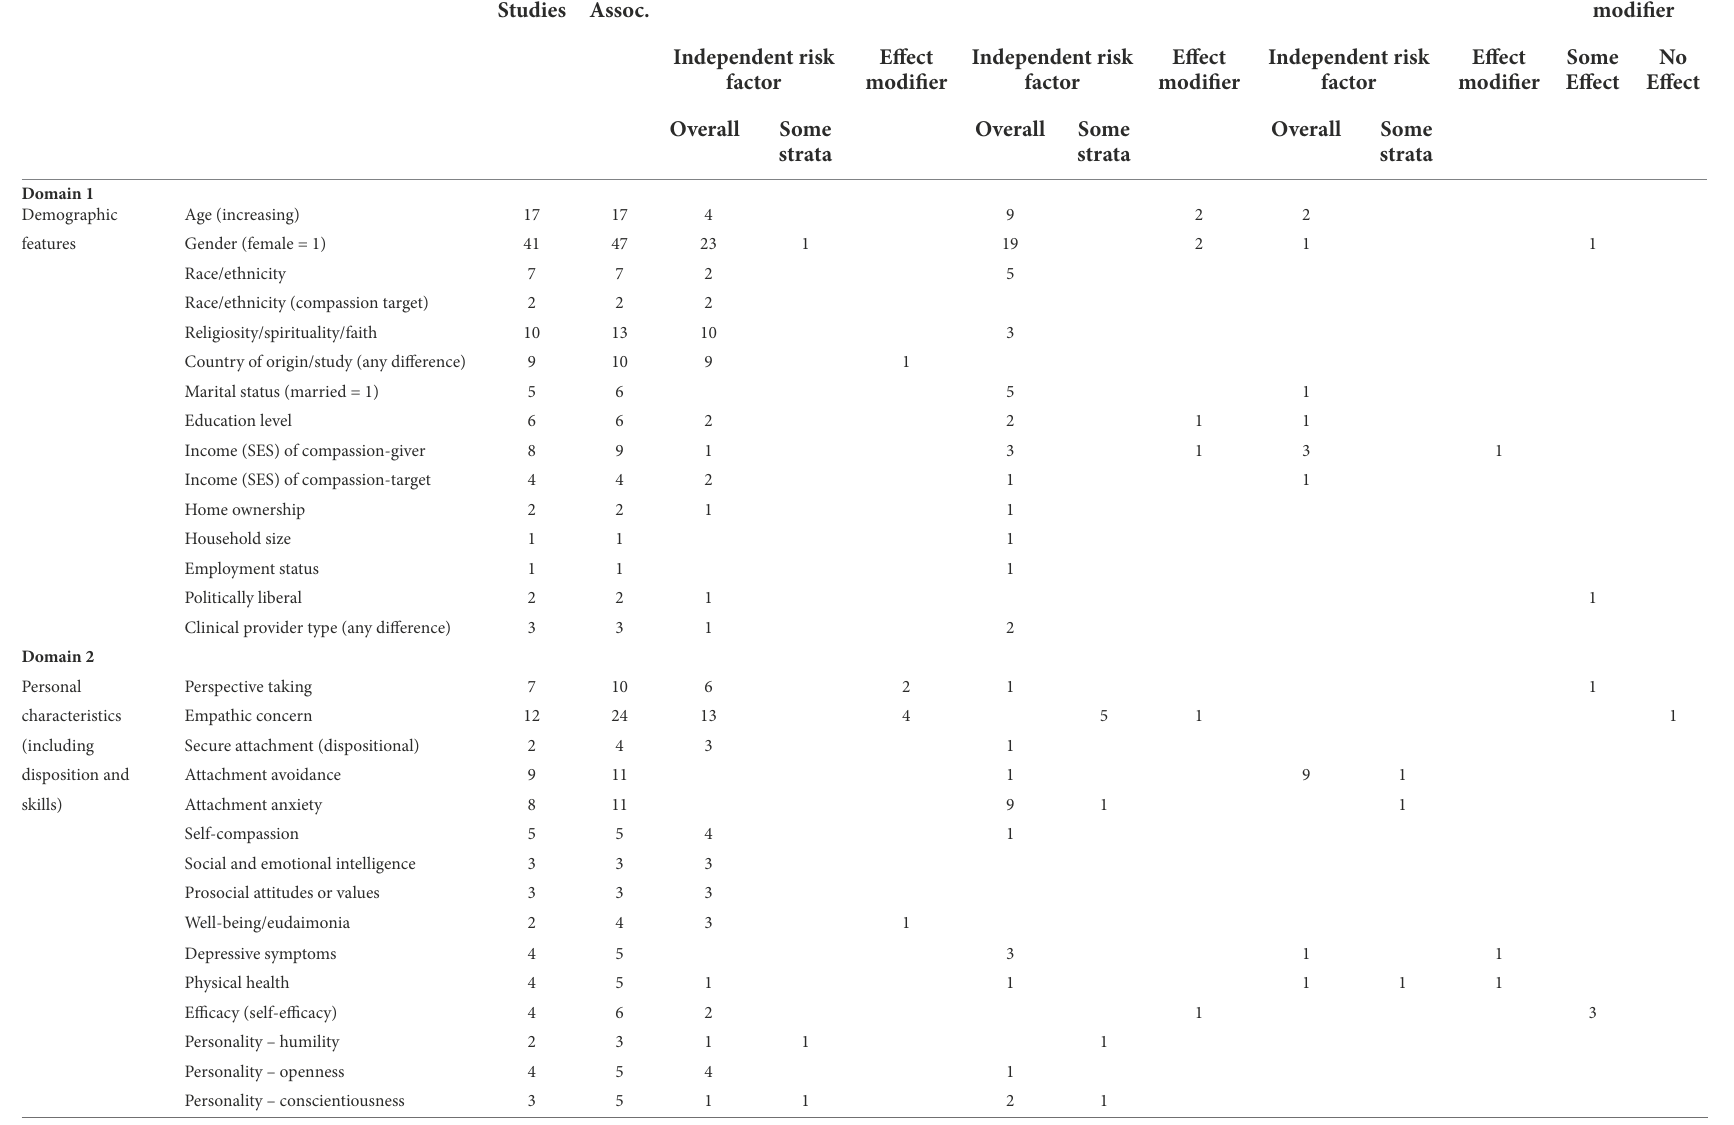
TABLE 3 Potential risk factors evaluated, by domain, and direction of statistically significant association with compassion as an outcome.*